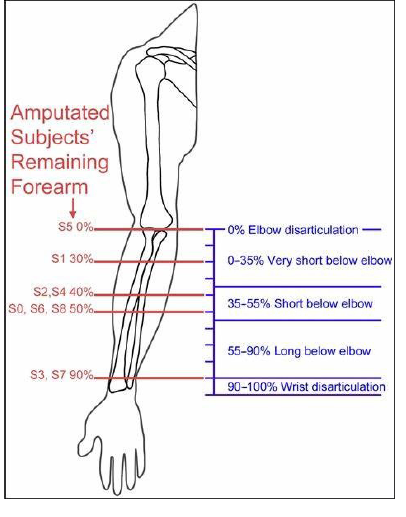
Figure 1. The proportion of residual limbs.